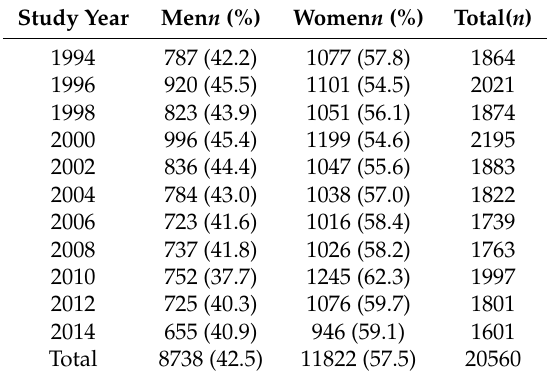
Table 1. Participants of a Lithuanian health behavior monitoring study,